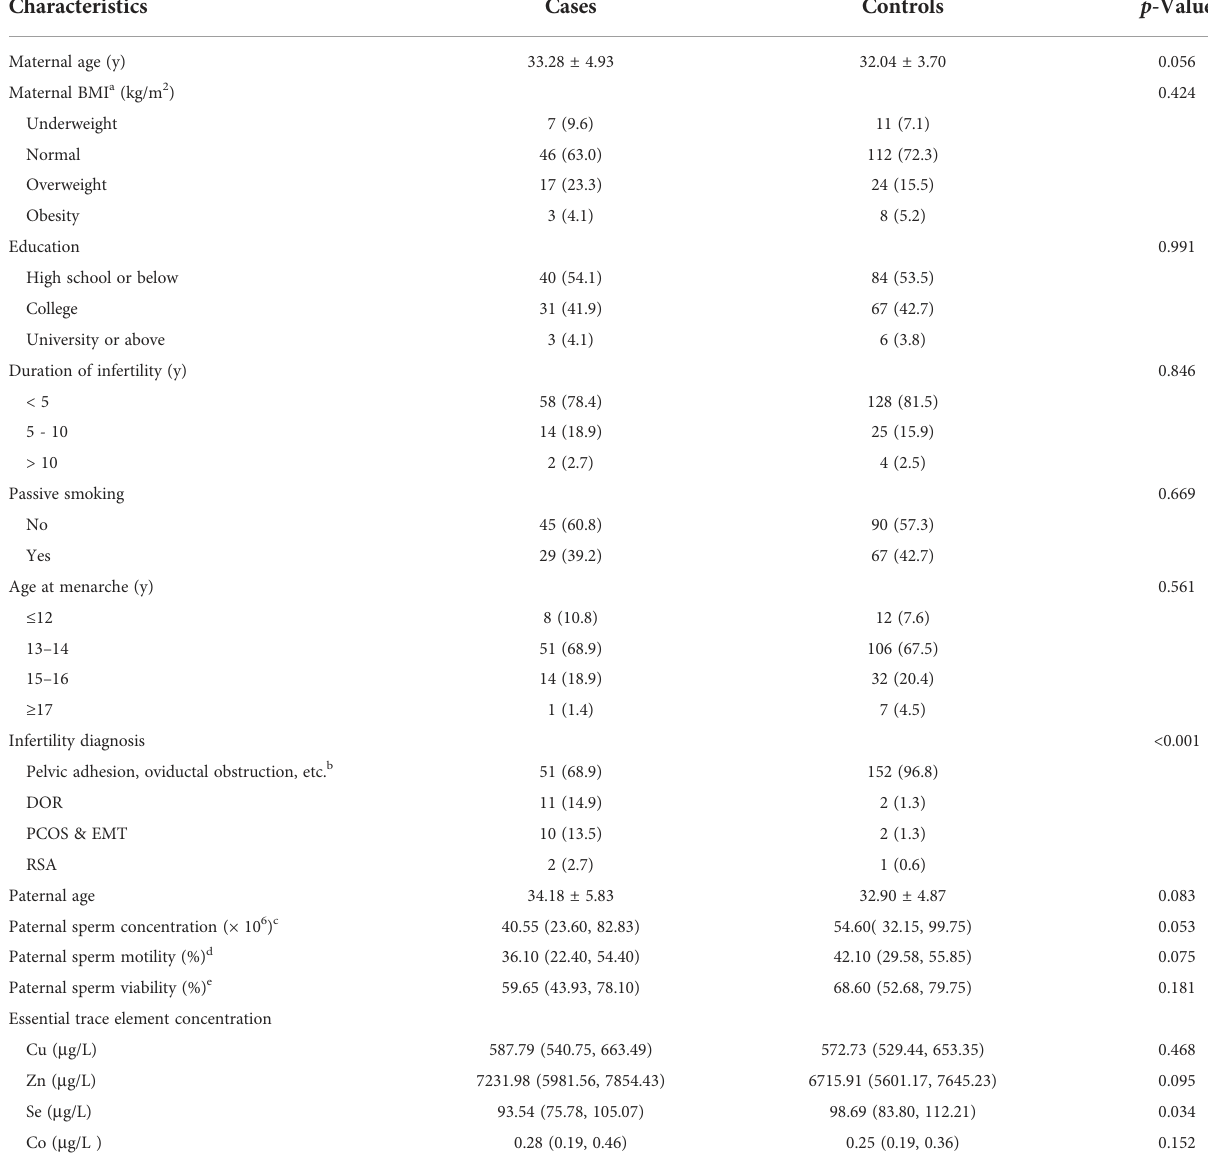
TABLE 1 Basic characteristics of cases and controls [Mean ± SD, Median ( P 25 , P 75 ) or n (%)].